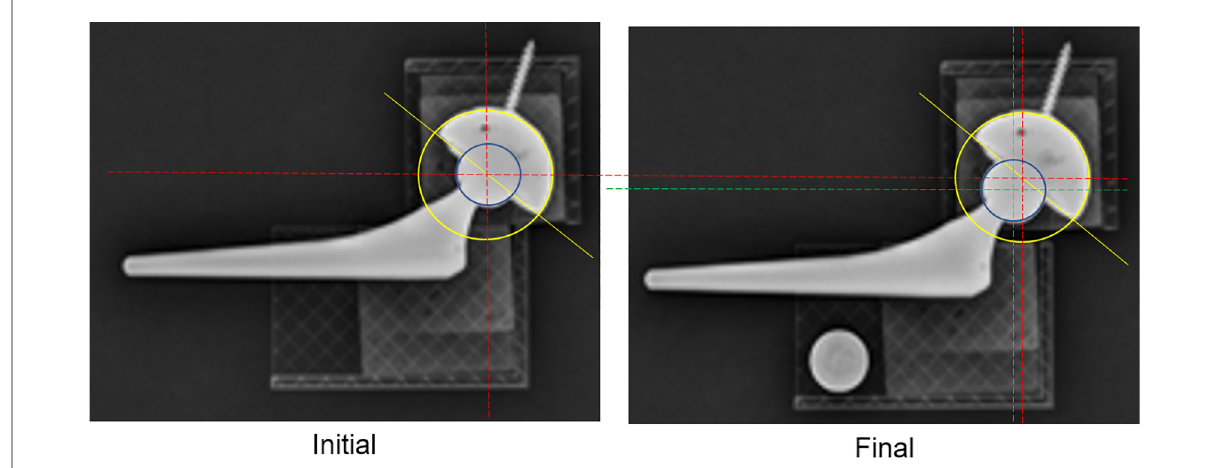
FIGURE 3 x-ray images of the initial (left) and fi nal (right) positions, simulating cup wear by a 6.67mm translation of the femoral stem normal to the equator plane of the